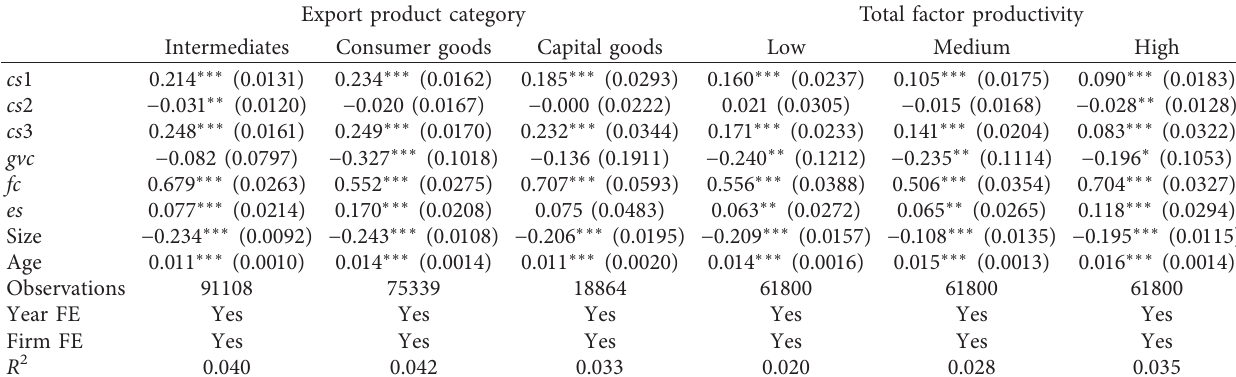
Table 5: The estimated results of regressions on subsamples classified by product category and total factor